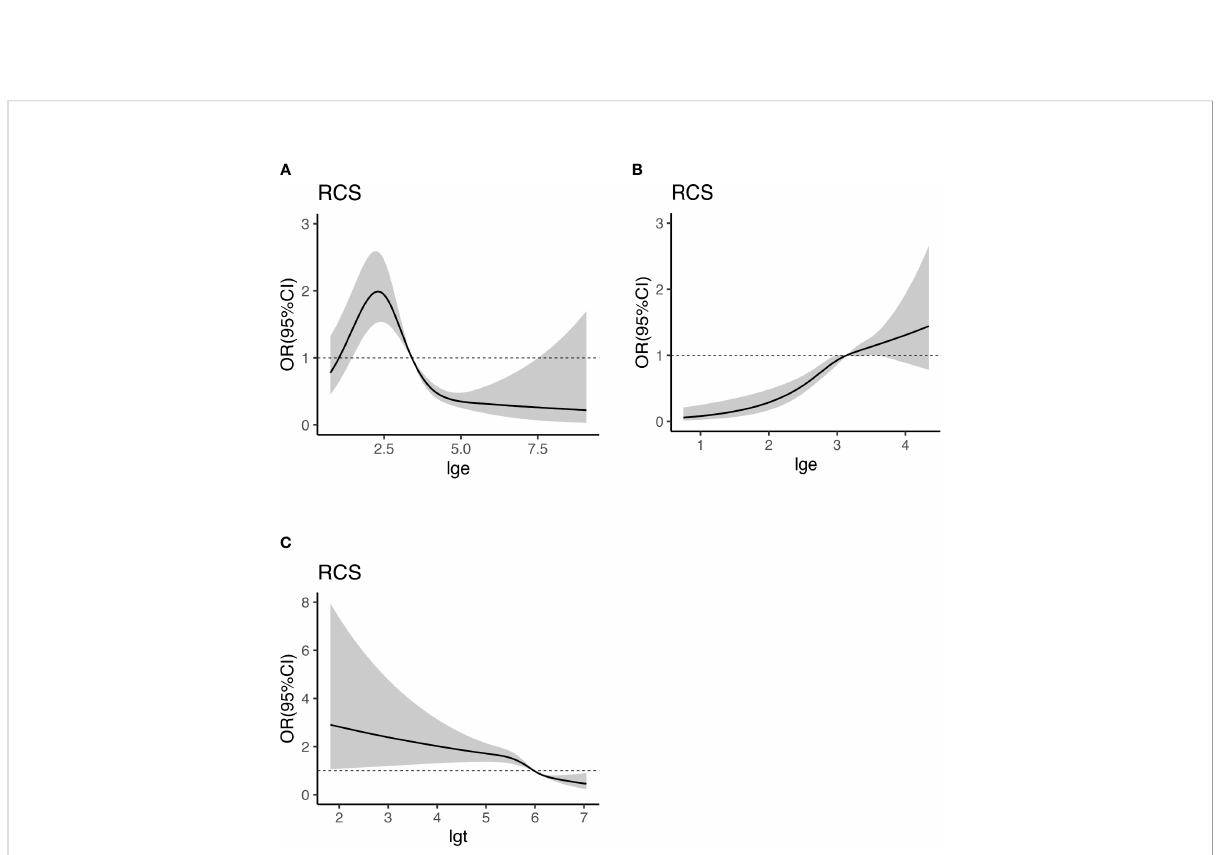
FIGURE 4 Dose-response relationship between E2, T, and HUA. RCS analysis shows a dose-response relationship between HUA and E2 in female (A) , E2 in male (B) , and T in male (C) . OR were adjusted for age, BMI, WC, HT, DM, MS, CKD, CVD, HLP and eth, PA, alcohol drinking. E2, estradiol; UA, uric acid; BMI, body mass index; WC, waist circumference; T, testosterone; HUA, hyperuricemia; HT, hypertension; CKD, chronic kidney disease; DM, diabetes mellitus; HLP, hyperlipidemia; MS, metabolic syndrome; CVD, cardiovascular disease; eth, ethnic; PA, physical activities; lge, logarithms of E2; lgt, logarithms of